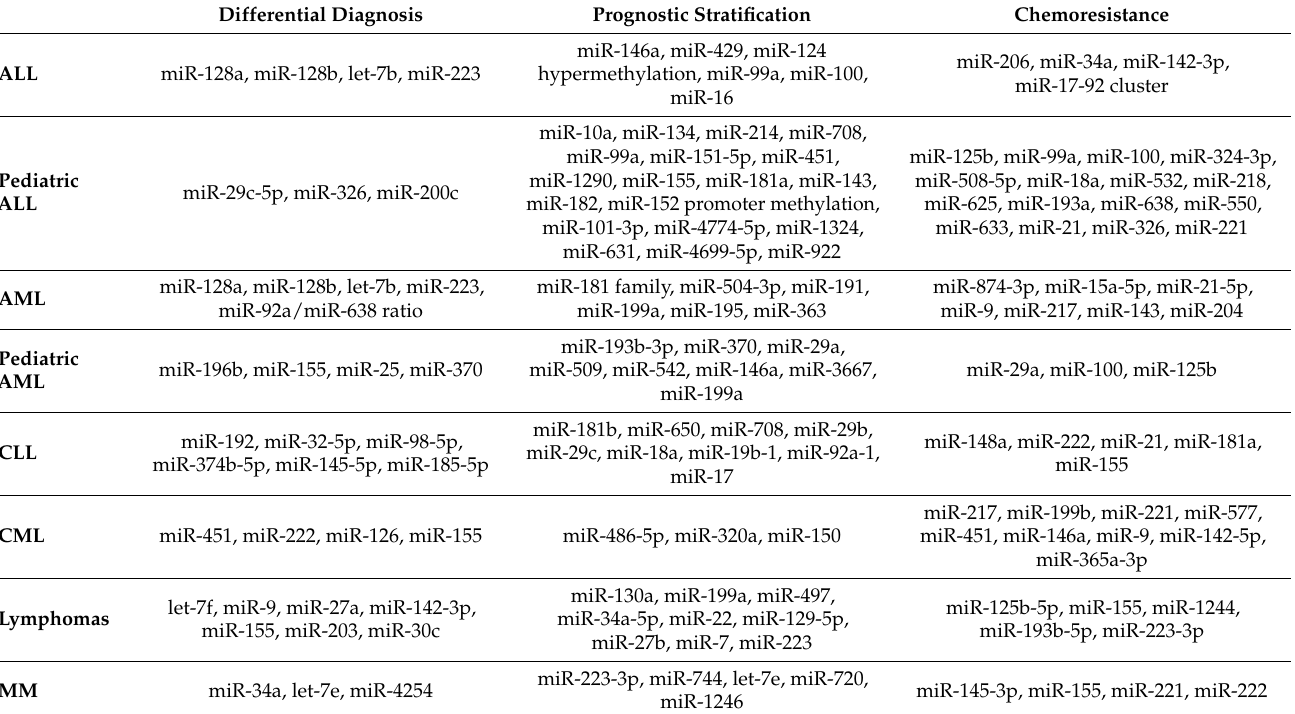
Table 1. Clinical applications of miRNAs in hematological malignancies. See references in the text. Differential